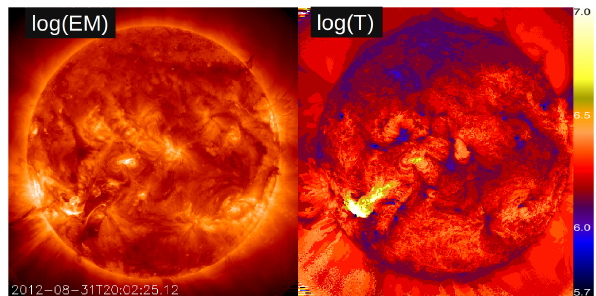
Figure 2. Emission Measure map (left panel) and Temperature map (right